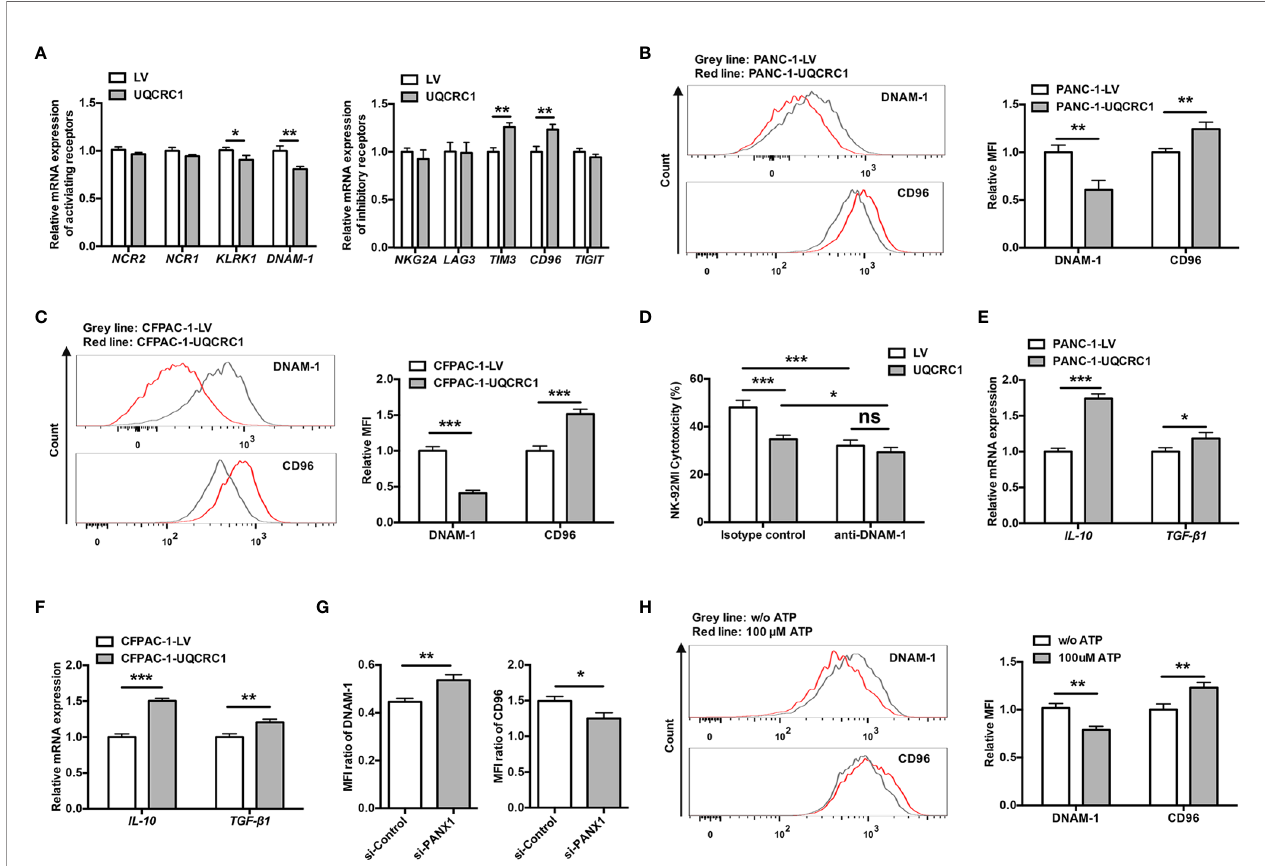
FIGURE 5 | UQCRC1/eATP axis induces NK cells to a more inhibitory phenotype via altering the balance of DNAM-1 and CD96. (A) The relative mRNA expression of genes encoding activating or inhibitory receptors in NK-92MI cells after co-culture with UQCRC1-overexpressing or control PANC-1 cells for 6 h. (B) Representative fl ow cytometry plots and quanti fi cation of DNAM-1 and CD96 on NK-92MI cells after co-cultured with UQCRC1-overexpressing (red) or control (grey) PANC-1 cells. (C) Representative fl ow cytometry plots and quanti fi cation of DNAM-1 and CD96 on NK-92MI cells after co-culture with UQCRC1- overexpressing (red) or control (grey) CFPAC-1 cells. (D) The cytotoxicity of NK-92MI cells against PANC-1 cells at an E: T ratio of 5:1 in the presence or absence of anti-DNAM-1 blocking antibody (n=4). (E) The relative mRNA levels of IL-10 and TGF- b 1 in NK-92MI cells after co-culture with UQCRC1-overexpressing or control PANC-1 or (F) CFPAC-1 cells. (G) The expression changes of DNAM-1 and CD96 on NK-92MI cells after co-culture with si-PANX1-transfected UQCRC1- overexpressing or control CFPAC-1 cells. The MFI ratio of DNAM-1 was calculated as the MFI of DNAM-1 in NK cells incubated with UQCRC1-overexpressing cells divided by the MFI of DNAM-1 in NK cells incubated with control cells. The same method was used to calculate the MFI ratio of CD96. (H) Representative fl ow cytometry plots and quanti fi cation of DNAM-1 and CD96 on NK-92MI cells after co-incubated with parental CFPAC-1 cells in the presence of 100 m M ATP for 6 h. All data are presented as the mean ± SD (n = 3 independent biological replicates unless otherwise indicated). *, p < 0.05; **, p < 0.01; ***, p < 0.001; ns, not signi fi